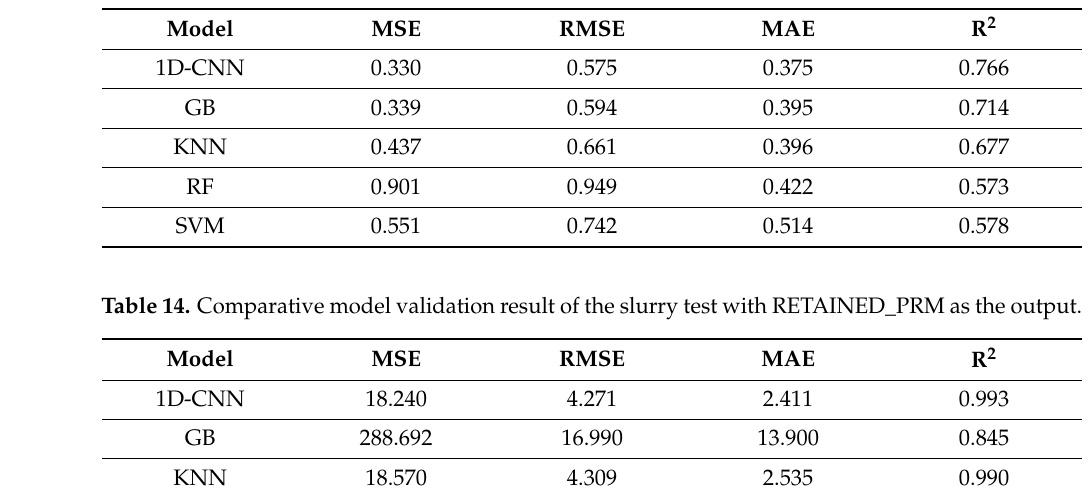
Table 13. Comparative model validation result of the slurry test with SAND_PRODUCED as the output.